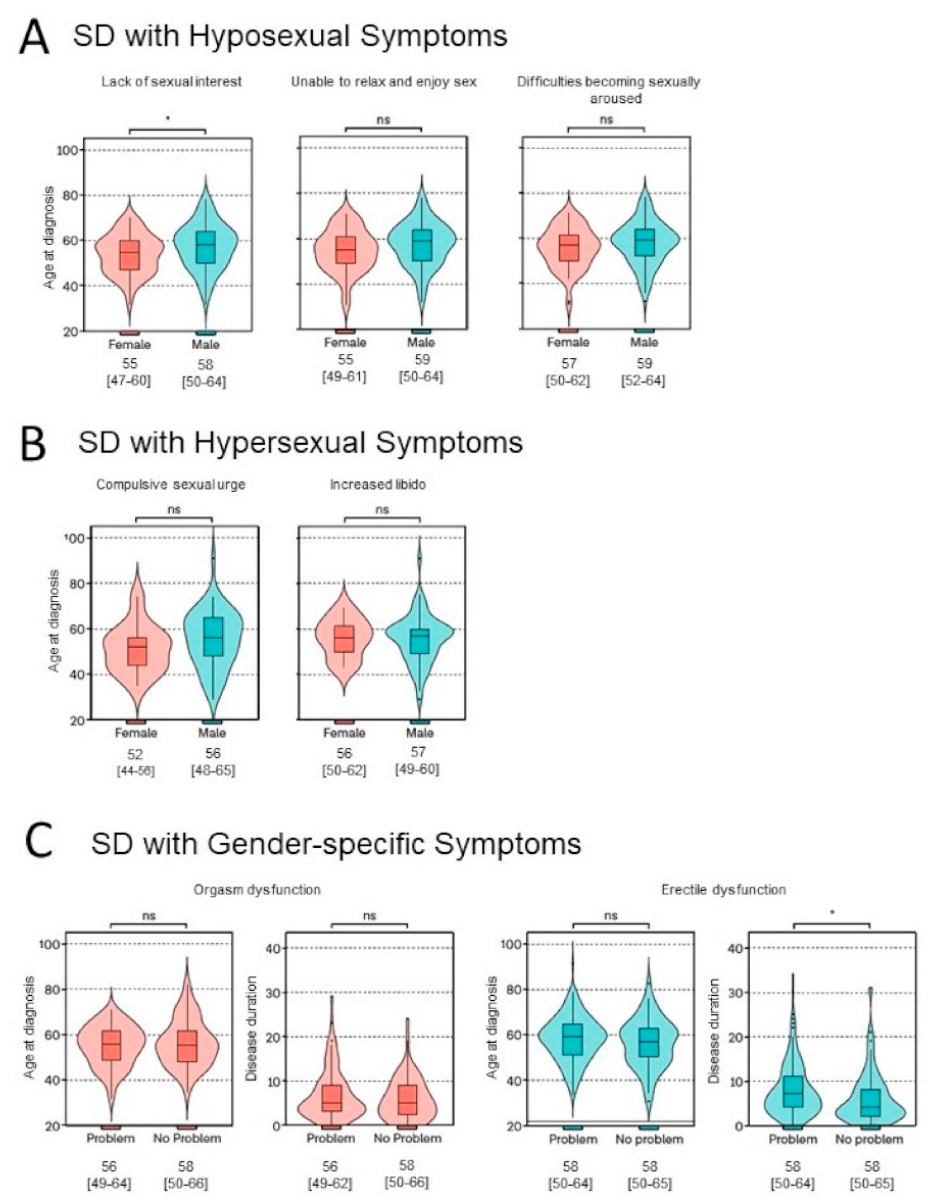
Figure 1. Demographics of sexual dysfunctions in detail. Median age at diagnosis (years) and interquartile range [IQR] are shown below the plots; ns, not significant; * significant correlation at p < 0.05; statistical test: Wilcoxon rank-sum